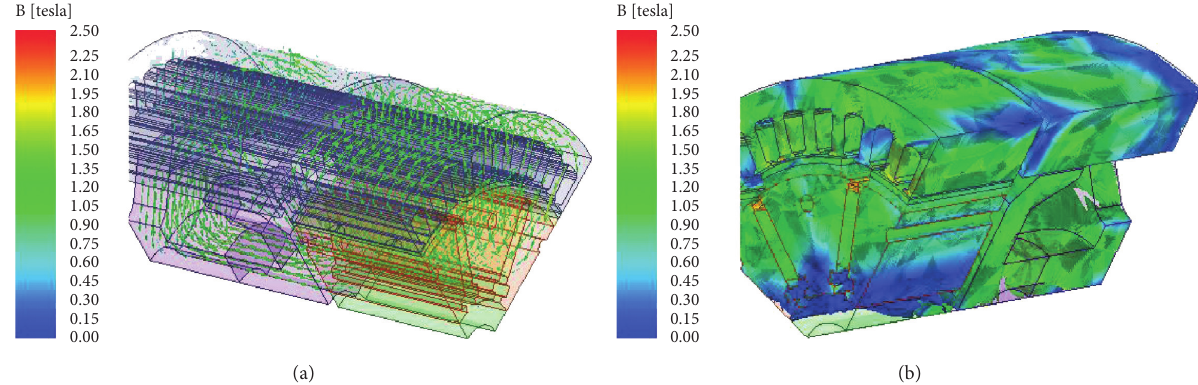
Figure 11: The field distribution of the PMCHEG. (a) Axial flux density vector diagram. (b) Magnetic flux density module value diagram. B [tesla] 2.50